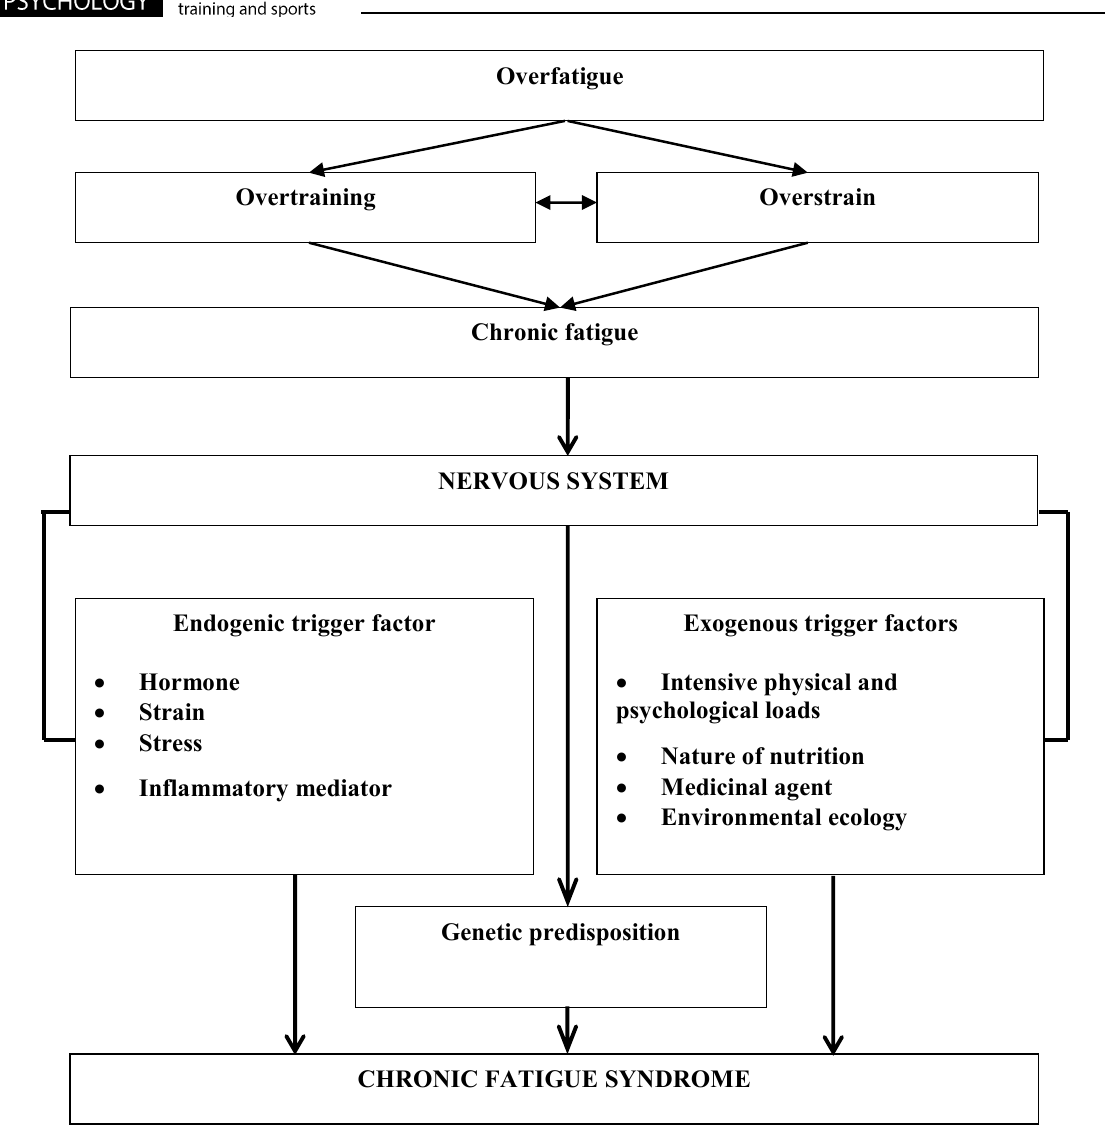
Fig. 3. Model of chronic fatigue and chronic fatigue syndrome’s formation in qualified